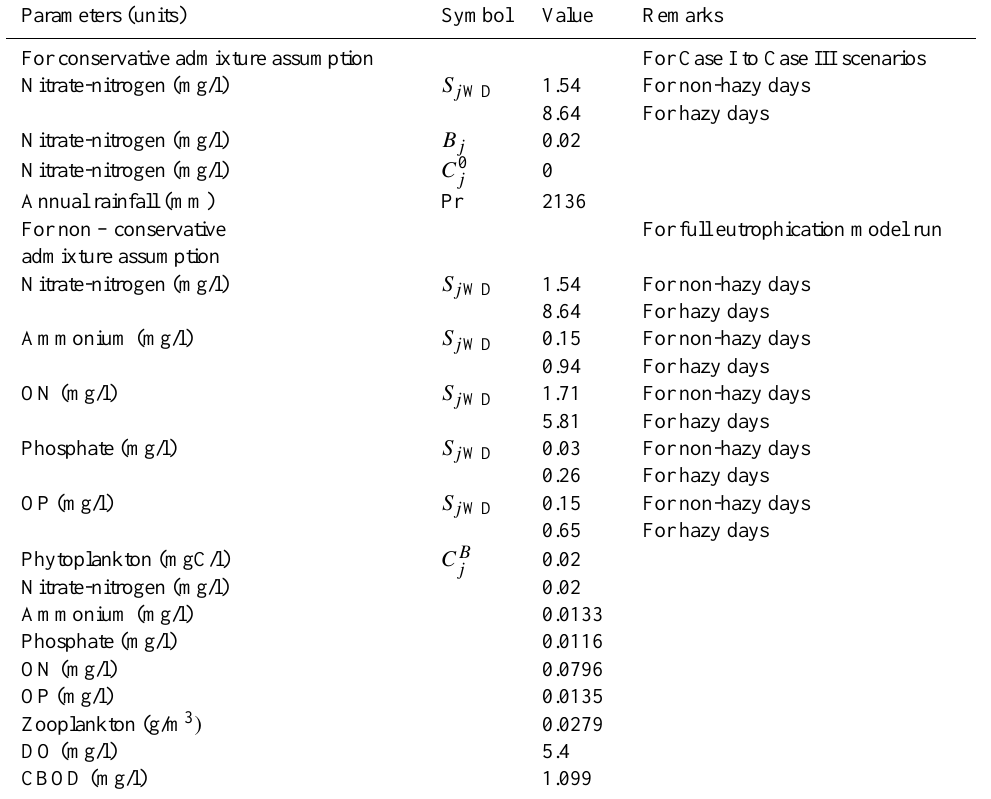
Table 3. Model inputs parameters and their values. Parameters (units) Symbol Value Remarks